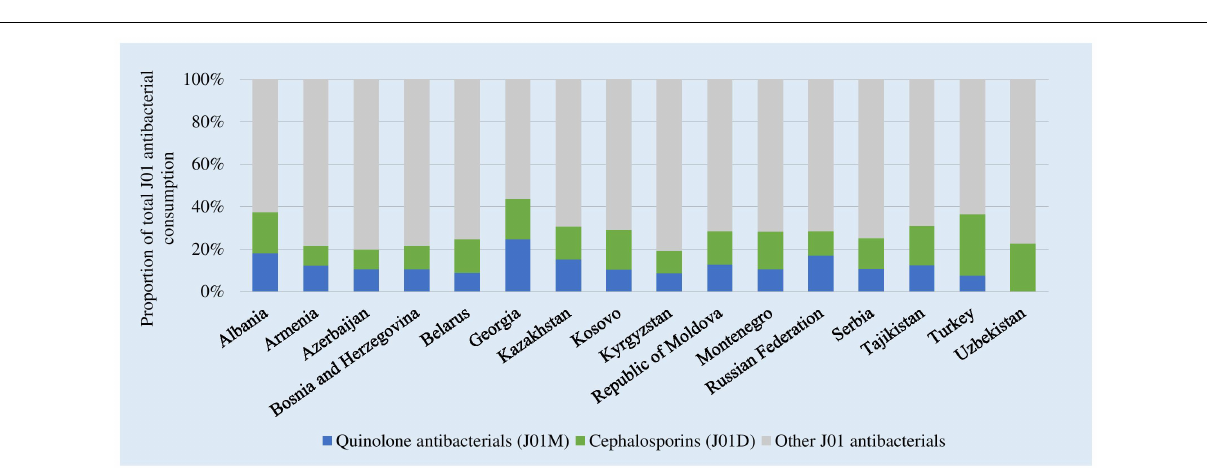
FIGURE 2 | Consumption of cephalosporins and quinolones as a proportion of the total consumption of J01 antibacterials, 2015. ∗ Kosovo [in accordance with United Nations Security Council resolution 1244